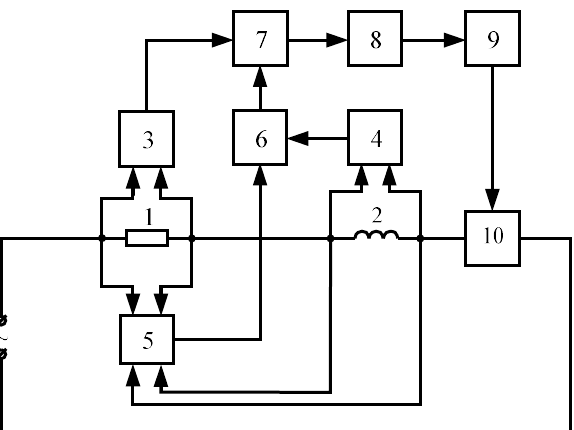
Figure 2. A schematic block diagram of a thermal protection device with the procedure for extracting DC components from alternating phased voltages and currents: 1, measuring shunt; 2, winding–stator temperature sensor; 3, 4, and 5, the first, second, and third recording blocks; 6 and 7, primary and secondary computing blocks; 8, block for recording the winding 2 temperature; 9, comparison block; and 10, executive unit.